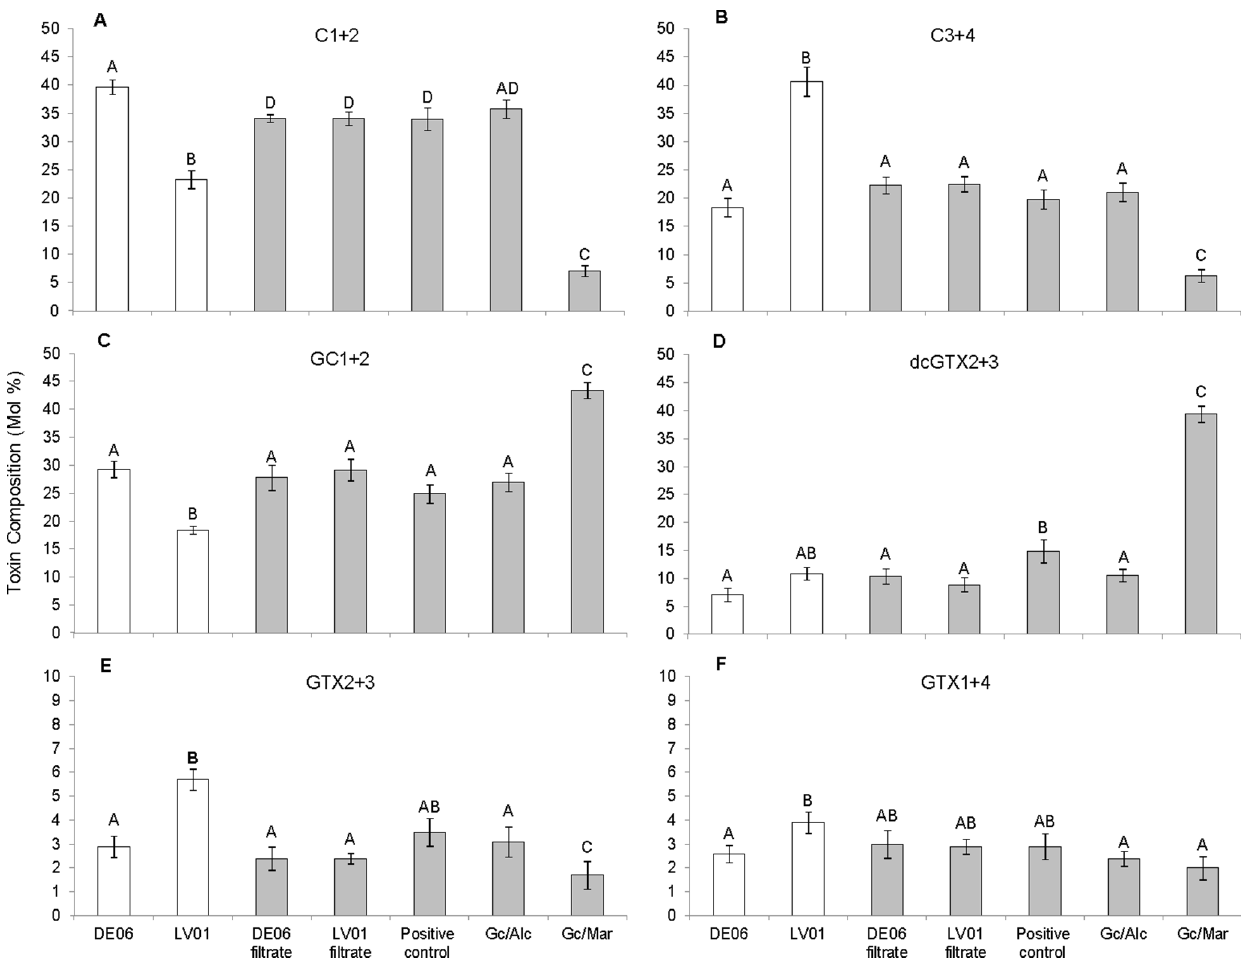
Figure 4. Toxin profiles (mol%) of each toxin group identified. The profiles of the identified toxin groups (C1 + 2, C3 + 4, GC1 + 2, dcGTX2 + 3, GTX2 + 3, and GTX1 + 4) from HPLC analysis on cultures at Day 25 (harvest), Error bars 6 SE, n=5. Superscripts indicate significant differences (p , 0.05), means labelled with the same letter are not significantly different.